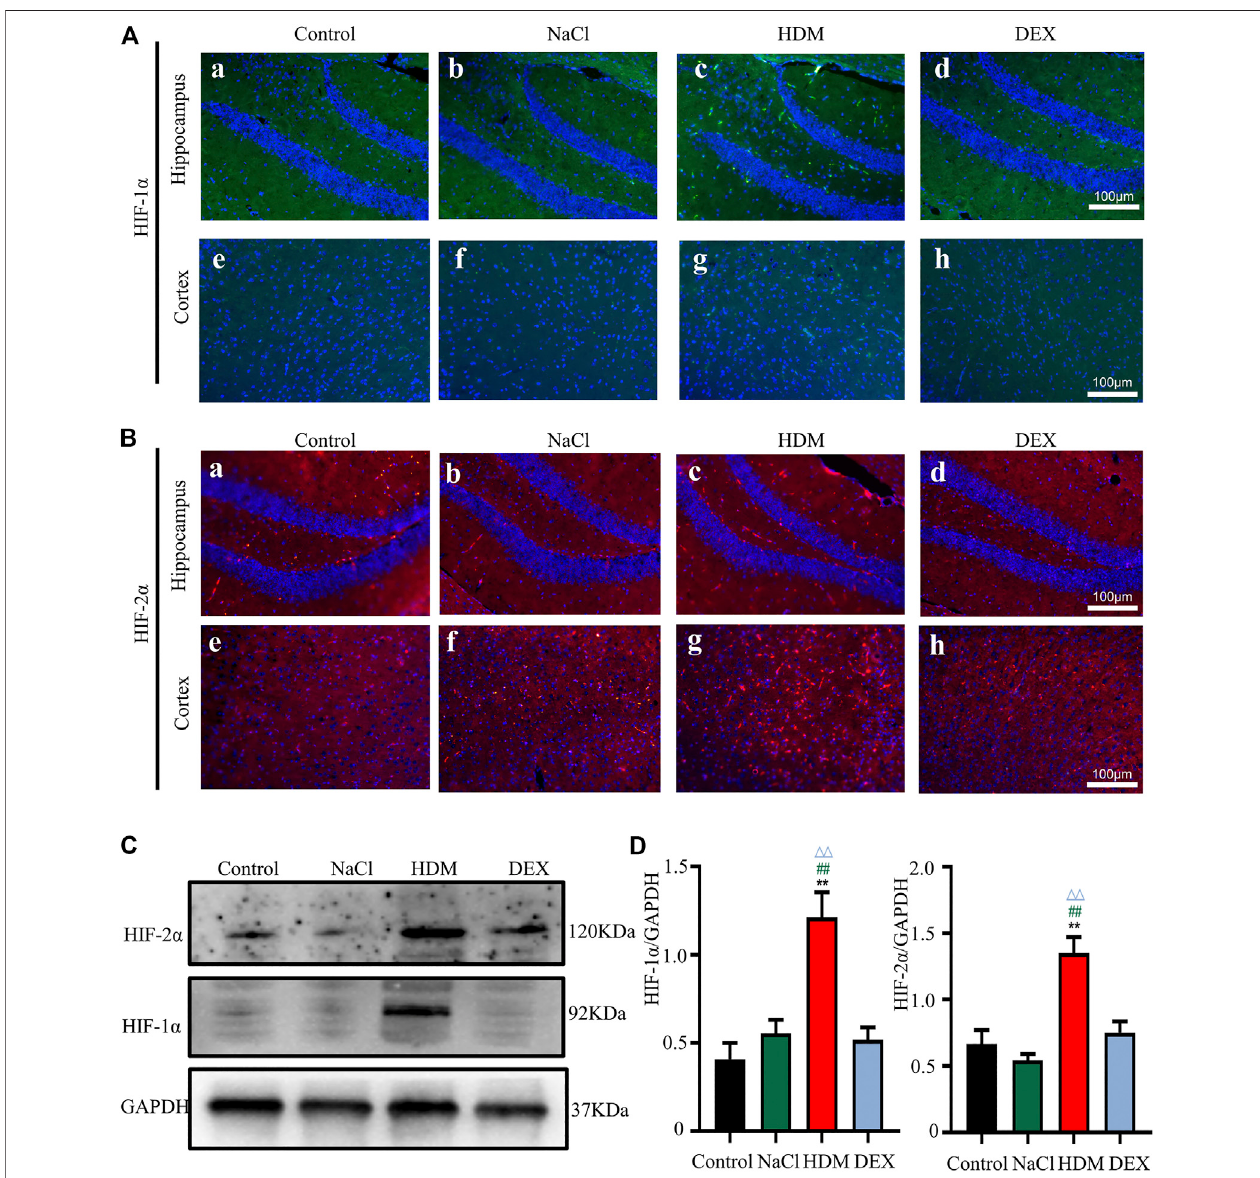
FIGURE7| Theexpression ofHIF-1 α andHIF-2 α inthebrainwasincreasedintheHDMgroup. [A(a-h)] ExpressionofHIF-1 α inhippocampusandcorticalregions ofbraintissue. [B(a-h)] ExpressionofHIF-2 α inhippocampus and corticalregionsofbraintissue. (C) Theprotein expression ofHIF-1 α and HIF-2 α inthebraintissuesof mice was detected by Western blot. (D) The results of the western blot were quanti fi ed. n (cid:1) 3. ** p < 0.01 between HDM group and Control group. ## p < 0.01 between HDM group and NaCl group. △△ p < 0.01 between HDM group and DEX group.